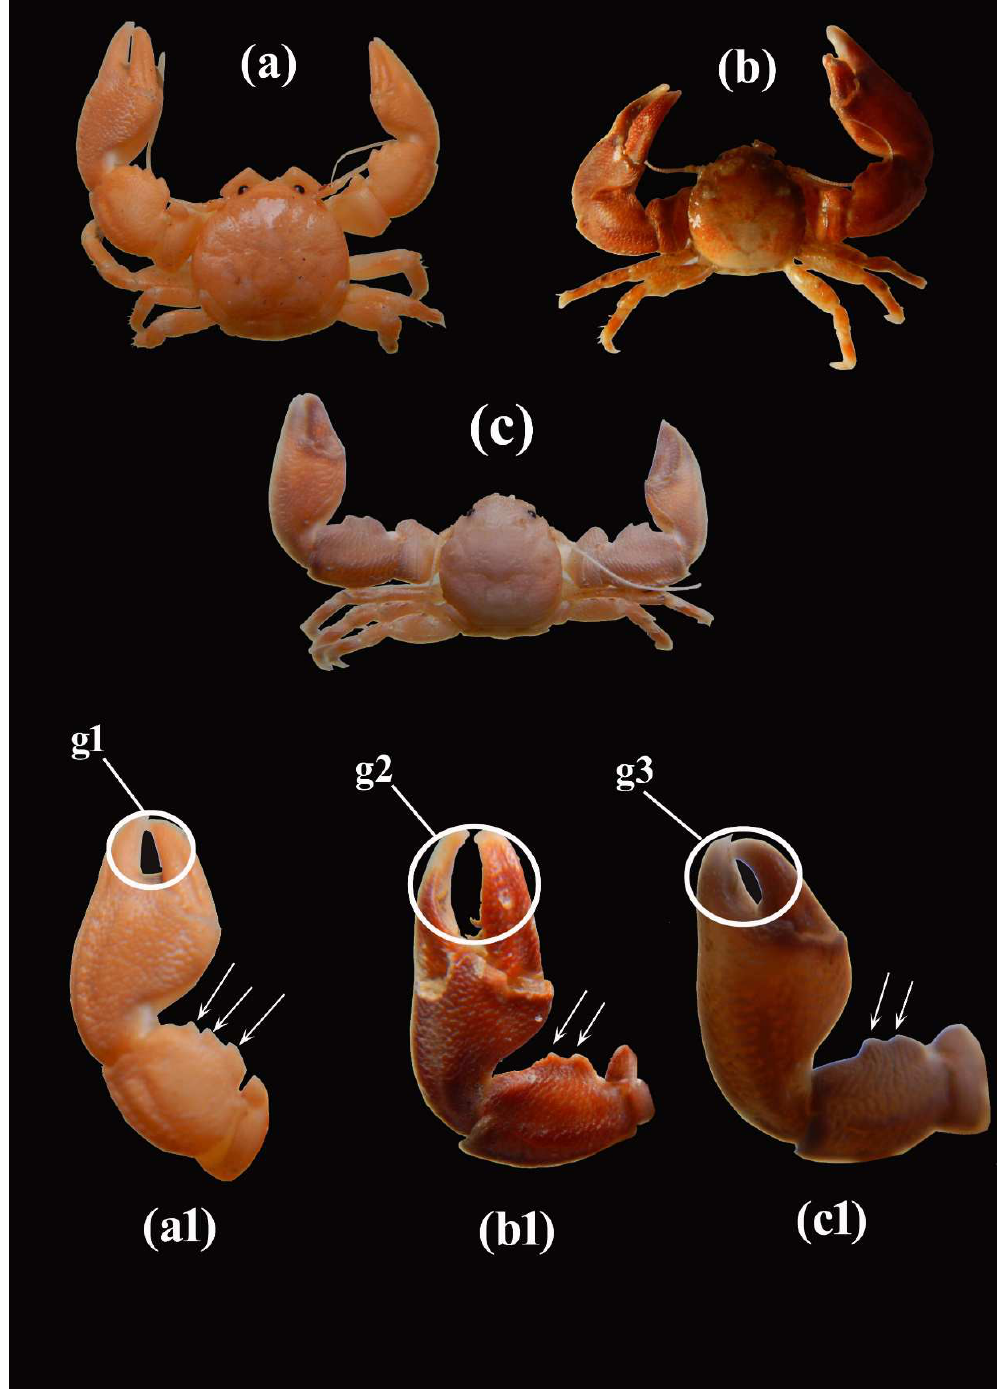
F IGURE 2. Morphological forms (a, b, c) of Ancylocheles gravelei . Cheliped Carpus of each forms (a1, b1, c1) indicating difference in gap (g1, g2, g3) between dactylus and